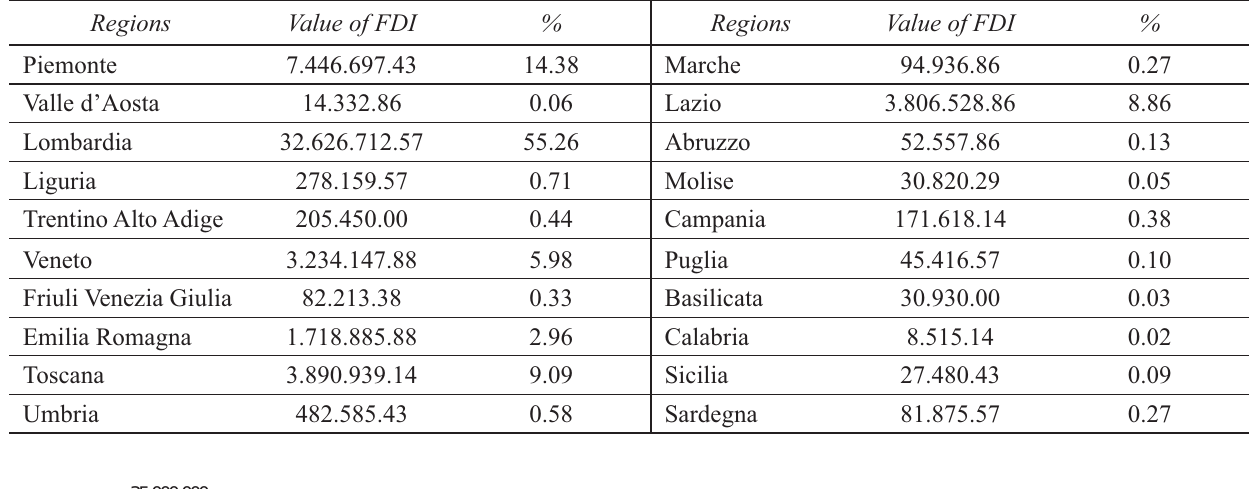
Table 1. Average FDI fl ow in the Italian regions between 1999 and 2005